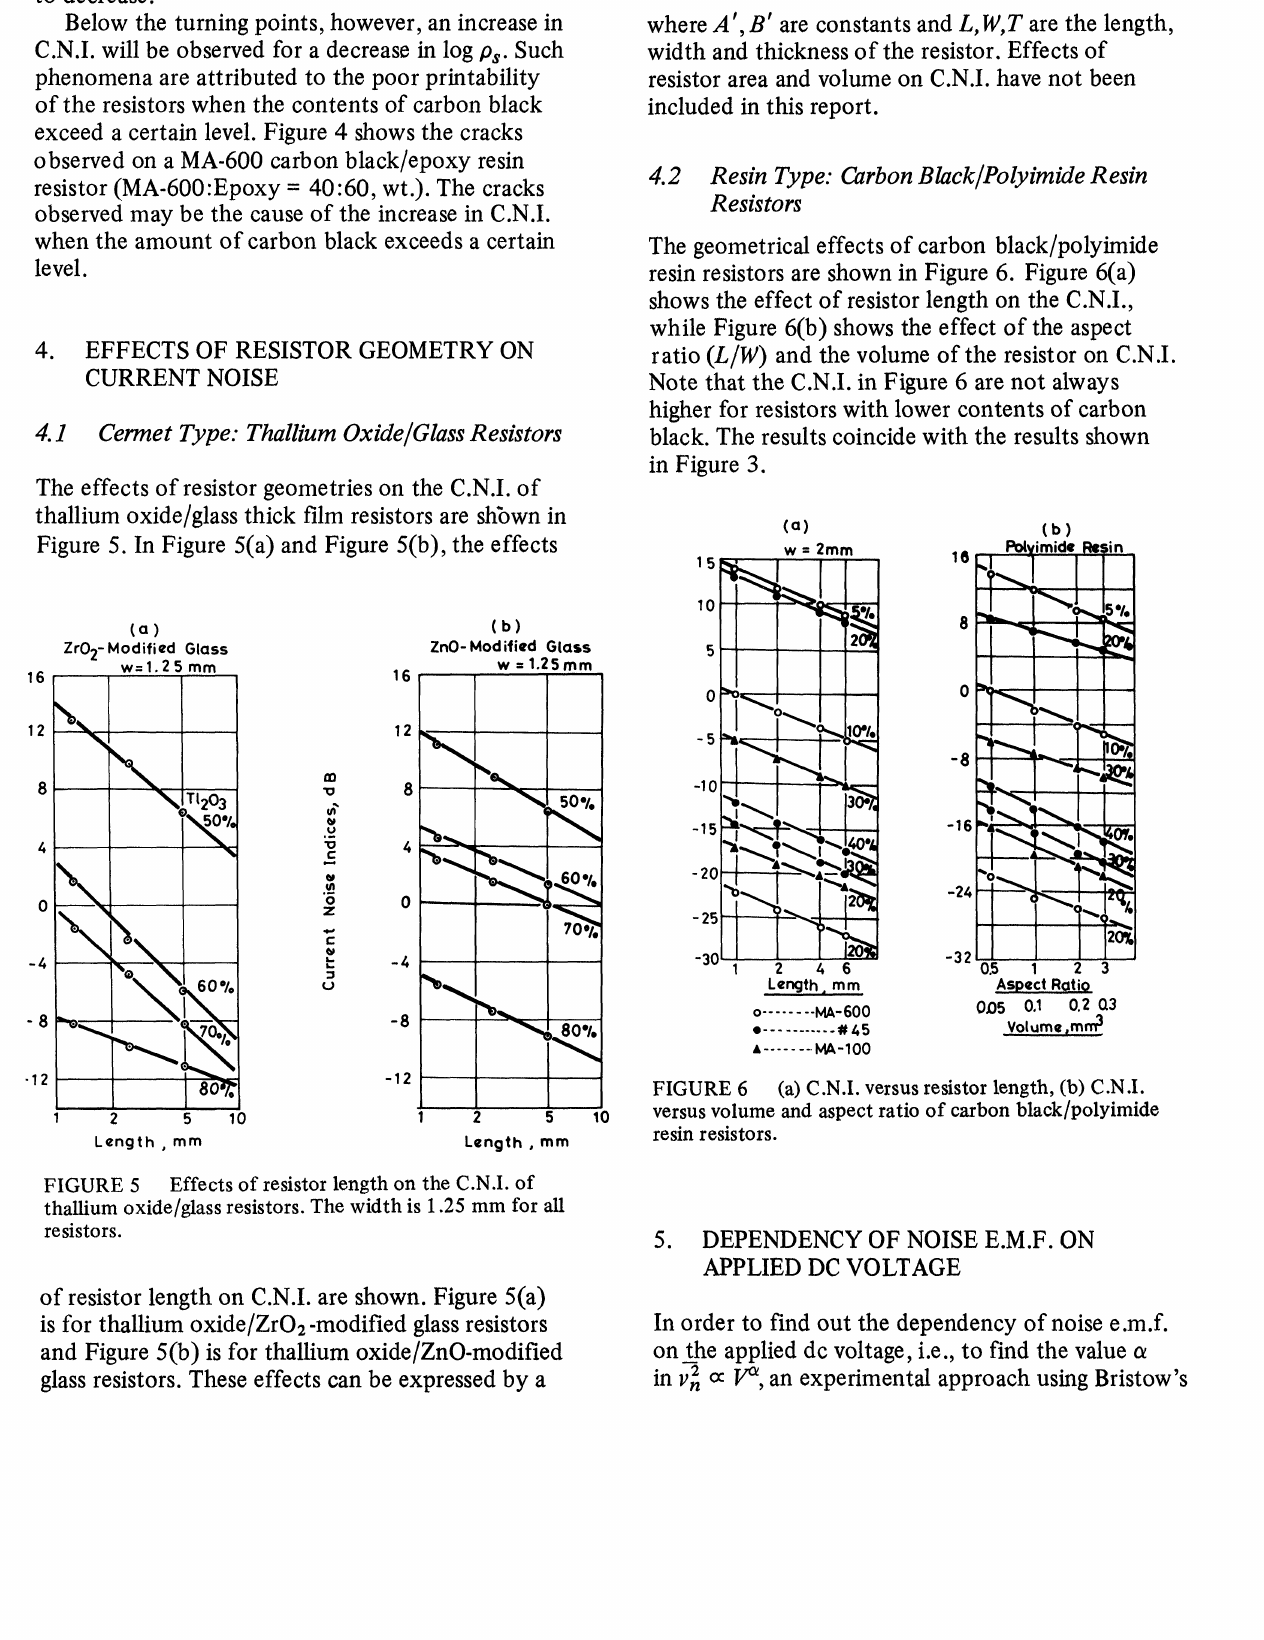
(a) C.N.I. versus resistor length, (b) C.N.I. versus volume and aspect ratio of carbon black/polyimide resin